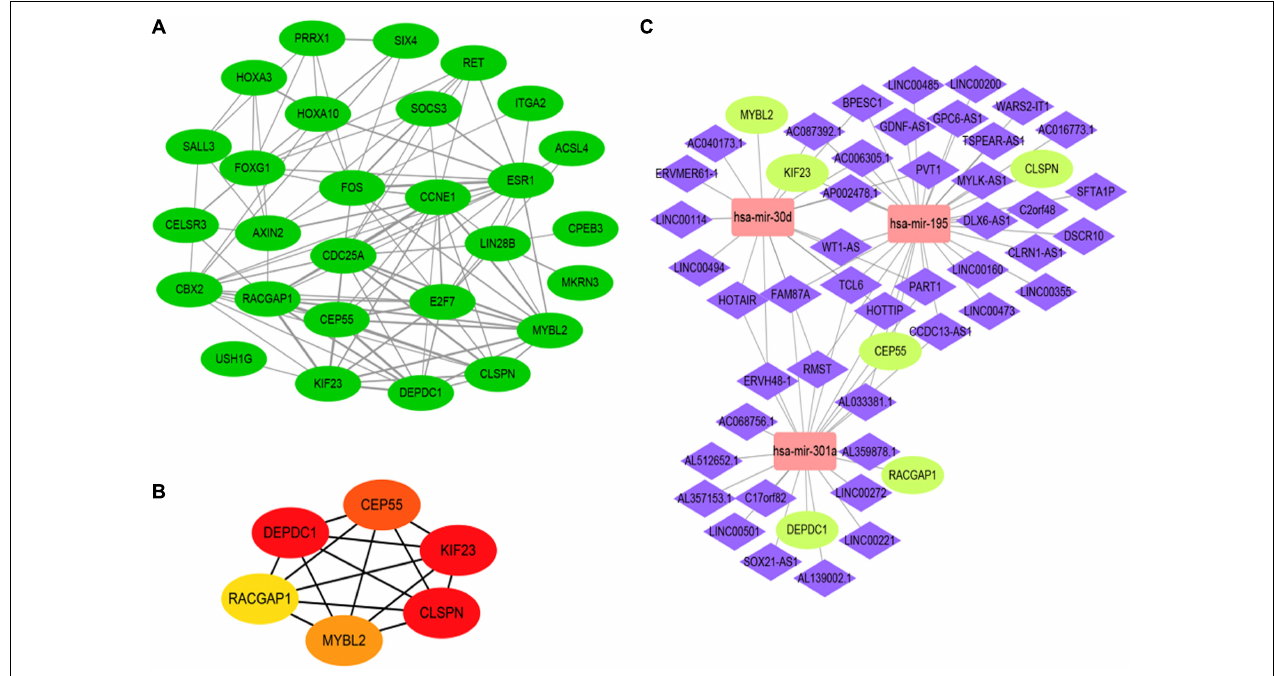
FIGURE 6 | The construction of hub gene associated with ceRNA network based on analysis of protein to protein interaction (PPI) network. The PPI network of DEGs (A) . PPI network of 6 hub genes, the color of nodes from red to yellow indicates that the connected degrees between each molecule with others decrease gradually (B) . the hub gene ceRNA regulatory network including 3 DEMs (rectangle) and 6 hub DEGs (ellipse) as well as 46 lncRNA (diamond) (C)